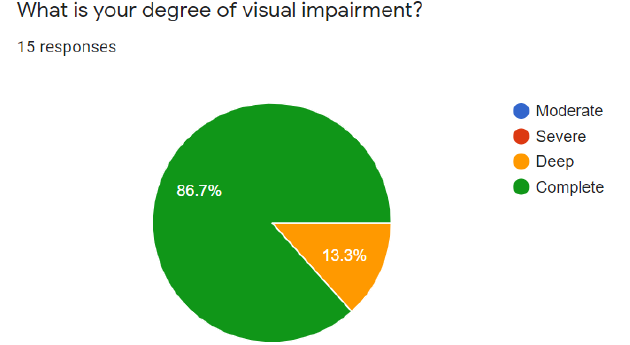
Figure 14. Percentage of visually impaired